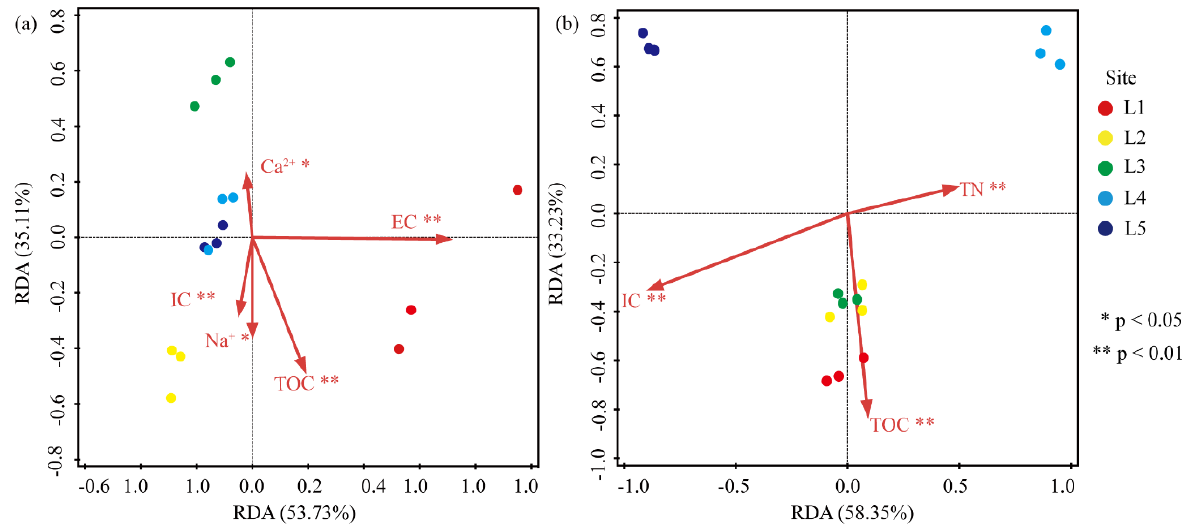
Figure 6. Correlation analyses among the sampling sites, environmental factors, and species rich- ness at HT ( a ) and LT ( b ). EC, electrical conductivity; TN, total nitrogen; IC, inorganic carbon; TOC, total organic carbon.